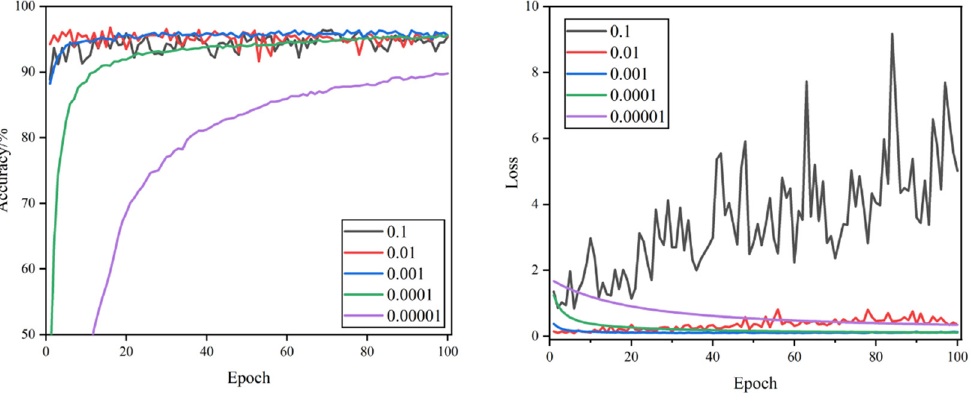
Figure 6. Validation accuracy and loss curves of different learning rates when dropout = 0.25.